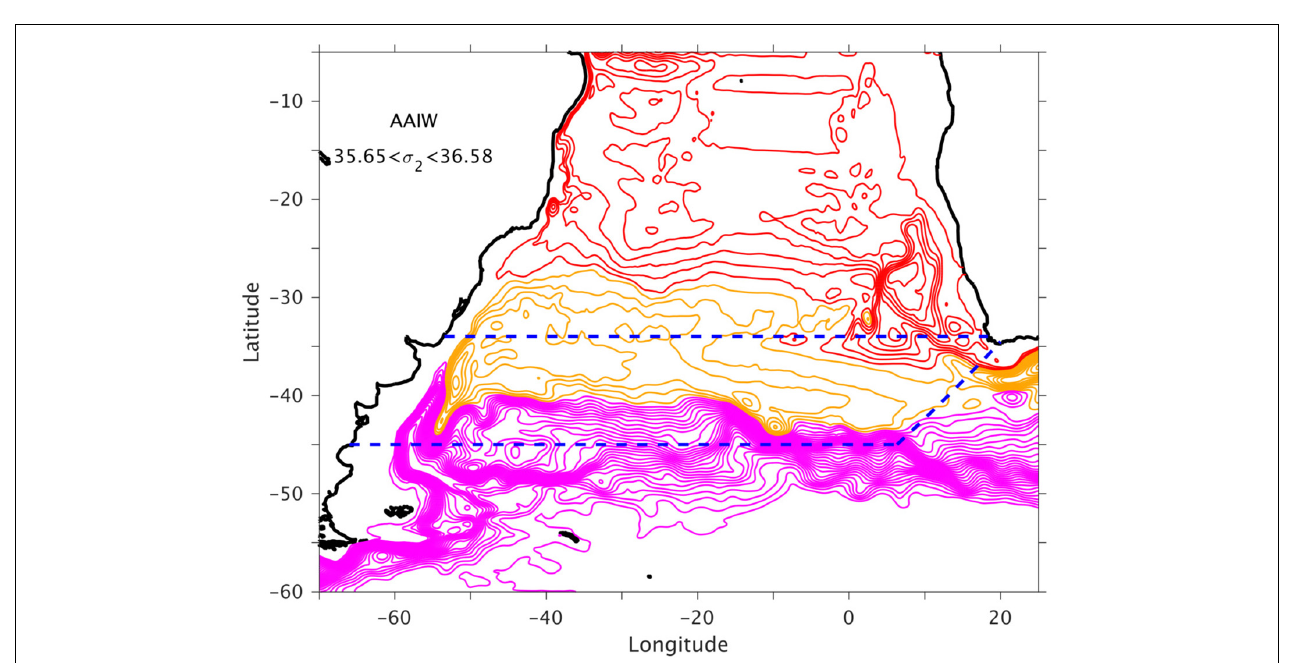
FIGURE 10 | Modeled long-term mean horizontal transport streamfunction (Sv) for the layer of AAIW (35.65 < σ 2 < 36.58 kg m − 3 ). Pink streamlines (increment of 4 Sv) is the ACC; red and orange streamlines denote AMOC contribution and the subtropical gyre of the South Atlantic (similar to Figure 15 ). The dashed blue lines denote 34 ◦ S, 45 ◦ S, and the GoodHope sections, across which the water properties of the northward and northwestward transports are examined in Figure 14